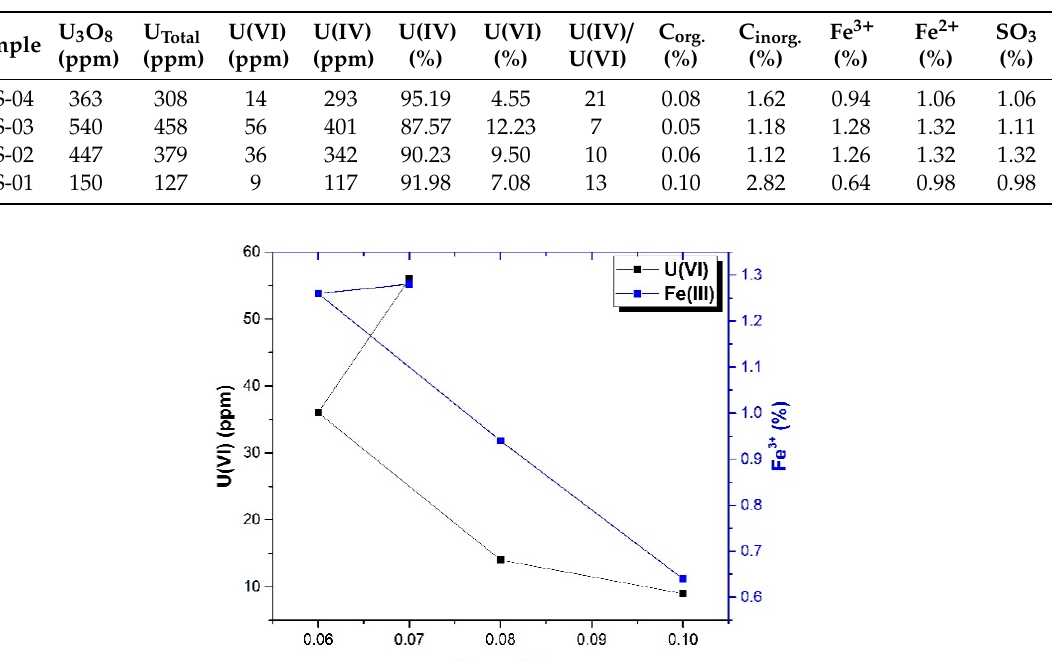
Table 7. Special characteristics of uranium ore.